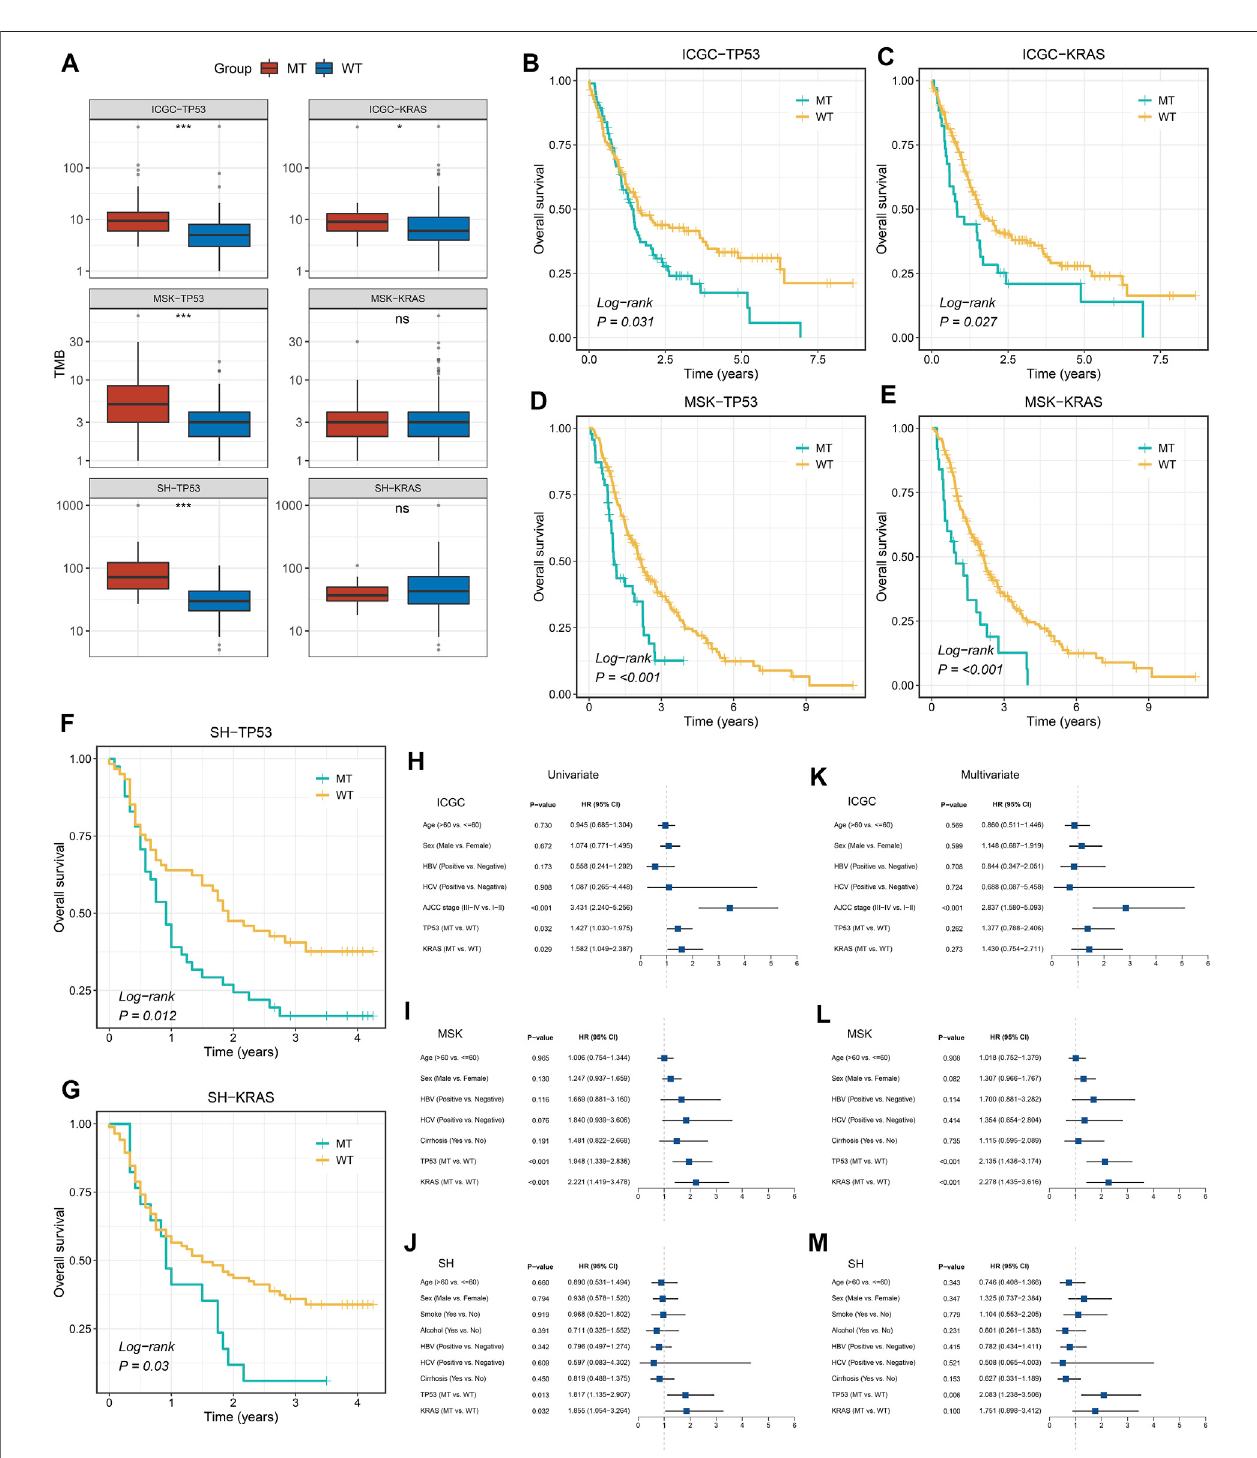
FIGURE2| GenemutationsareassociatedwithTMBandclinicalprognosis. (A) TP53andKRASmutationsareassociatedwithahigherTMB. (B – G) Kaplan – Meier survival analysis of patients with TP53 or KRAS mutations in the three cohorts. (H – M) Univariate and multivariate Cox regression analysis. ns p > 0.05; * p < 0.05; ** p < 0.01; *** p < 0.001.